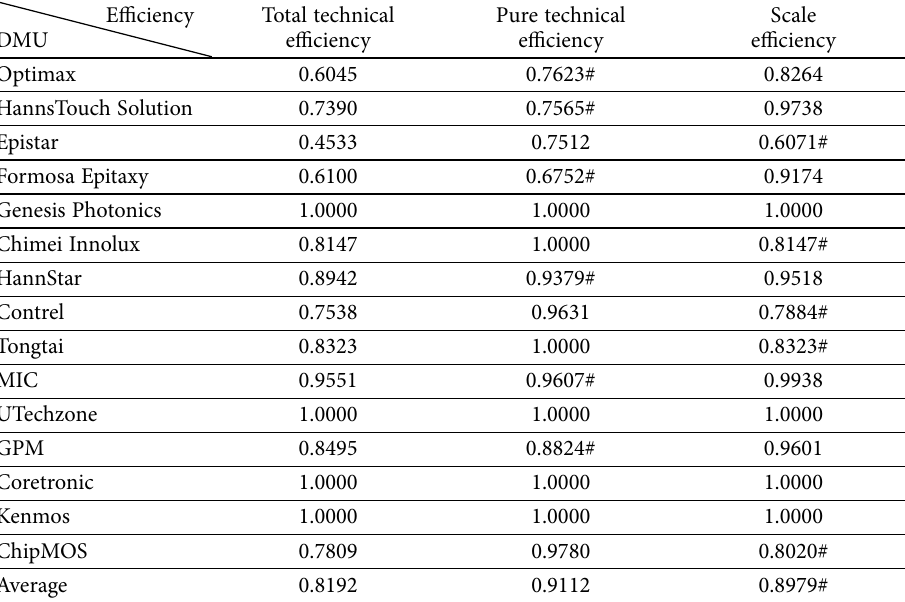
Table 4. Average total technical efficiency, pure technical efficiency, scale efficiency between